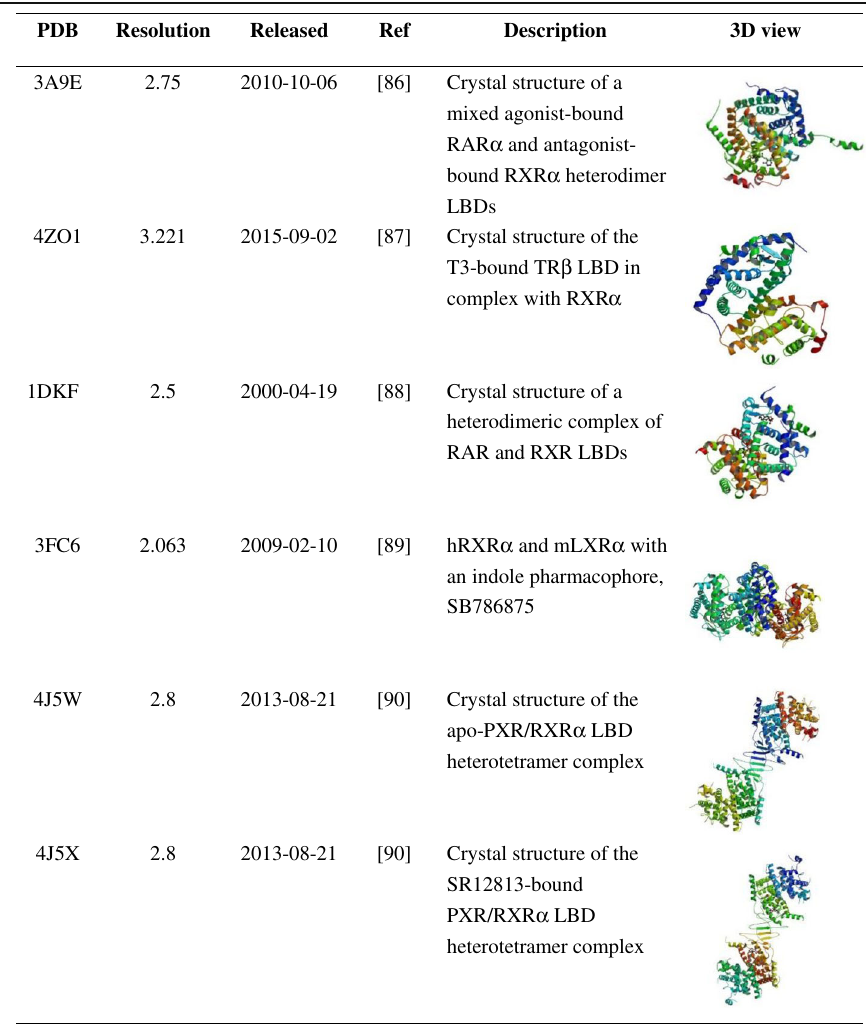
Table 2 The 3D structure of RXR α with other nuclear receptors [86 –